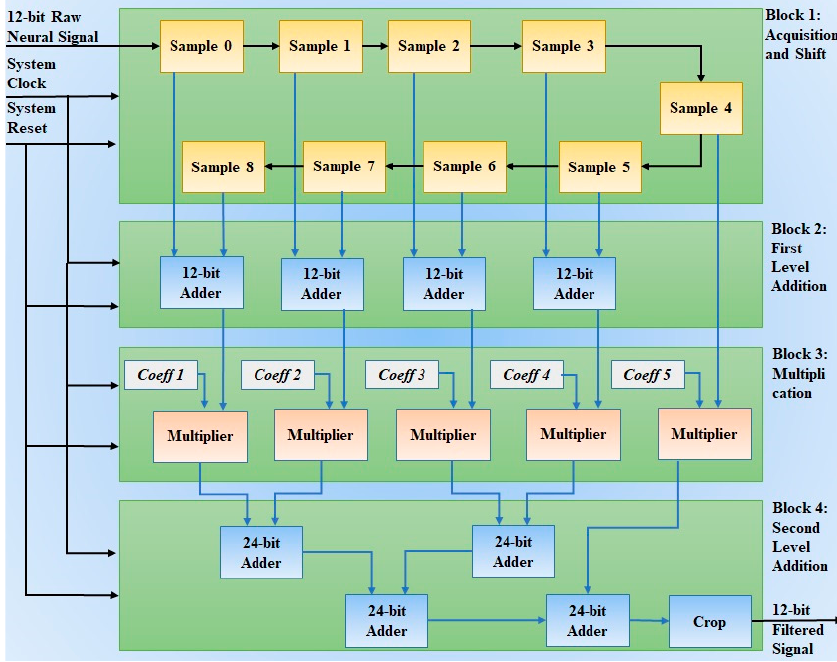
Figure 4. Implemented FIR filter.